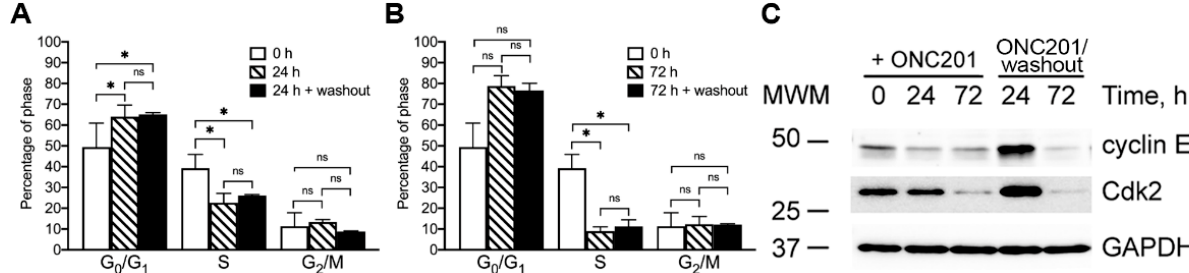
Figure 5. ONC201 induces G 1 /S cell cycle arrest of BT474 cells. ( A ), Distribution of BT474 cells in cell cycle phases before (0 h), after 24 h treatment with 10 µ M ONC201, and after subsequent 120 h washout. ( B ), Distribution of BT474 cells in cell cycle phases before (0 h), after 72 h treatment with 10 µ M ONC201, and after subsequent 120 h washout. ( C ), Representative Western blots of cell cycle regulatory proteins following treatment with 10 µ M ONC201 (+ONC201) and subsequent 120 h washout (ONC201/(washout). Shown are mean ± SD ( A , B ) and representative Western blots ( C ) from at least three independent experiments. The data were analyzed using one-way ANOVA with post-hoc Bonferroni test, * p < 0.05, “ns”, non-significant.